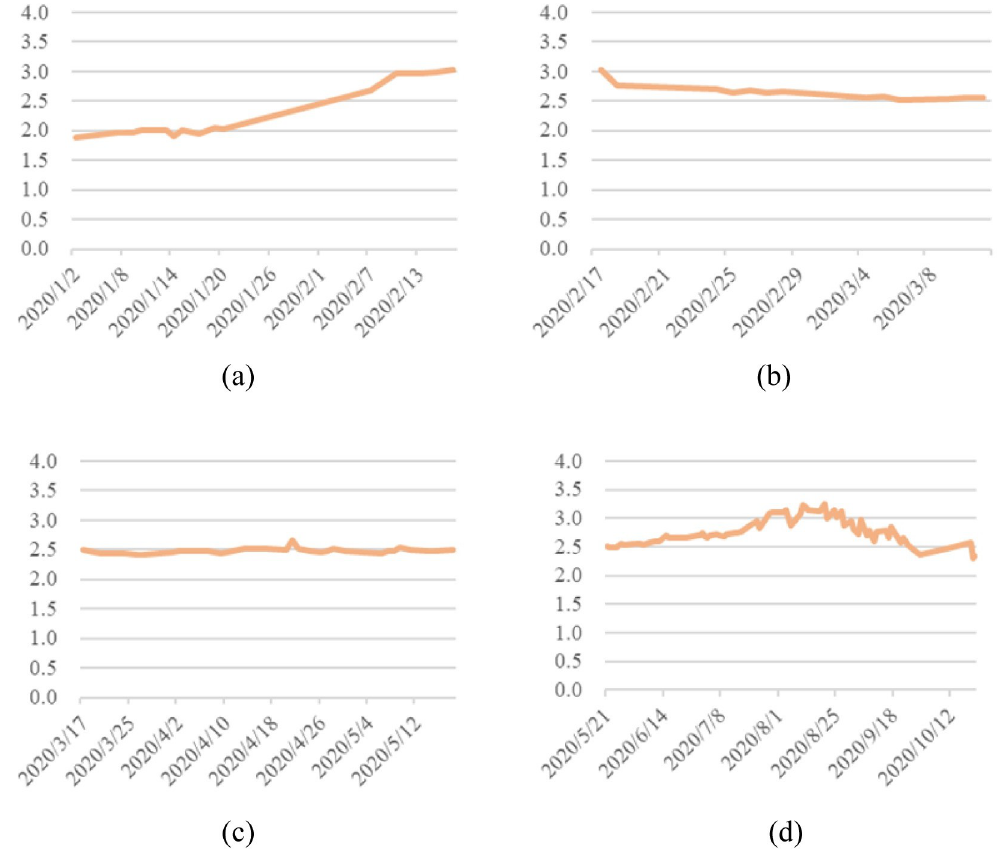
Fig 4. Carrot prices in 2020. (a) During the outbreak phase. (b) During the epidemic mitigation phase. (c) During the epidemic interruption phase. (d) During the normalization phase of epidemic